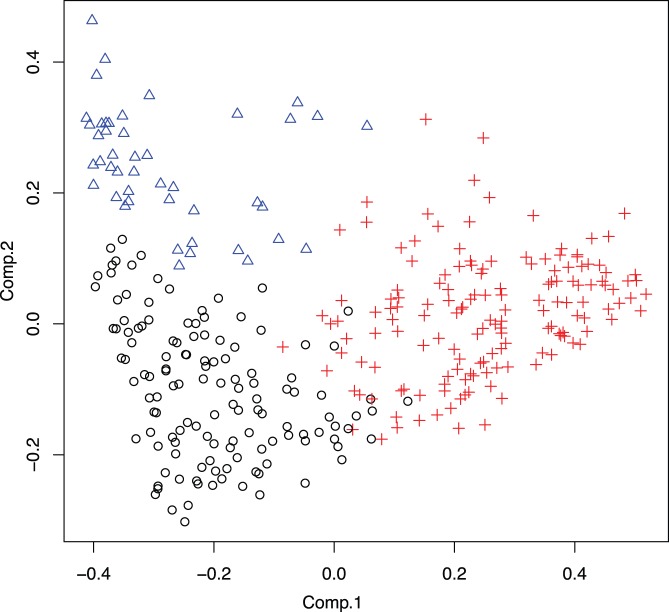
UniFrac Principle Co-Ordinates Analysis plot, showing each study sample positioned according to its first two principle coordinates.These are determined by the classical multidimensional scaling algorithm so that the Euclidean distance between points approximates the unweighted UniFrac distance between the OTU profiles of the corresponding samples, colored by Abundance of (A) Prevotella, (B) Bacteroides, and (C) Firmicutes.